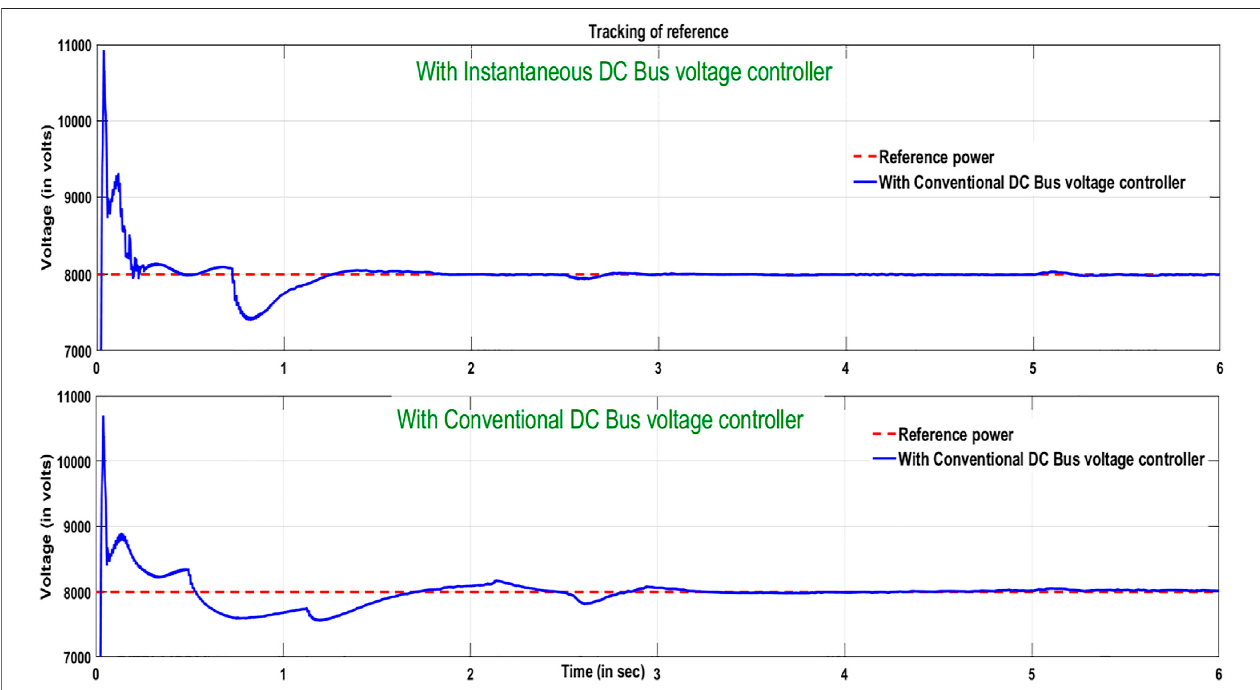
FIGURE 8 | DC link voltage controllers in tracking of reference